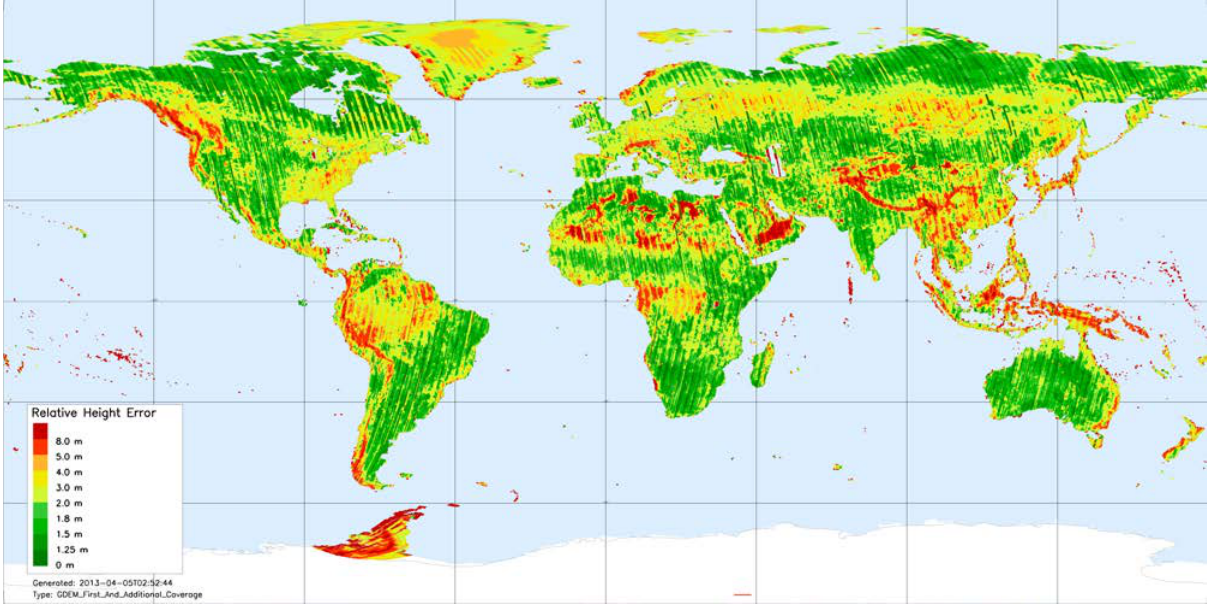
Figure 5: Global height error map of TanDEM-X data takes acquired during the first year campaign plus some additional acquisitions between Dec. 2010 and Jun. 2012. The acquisitions of the second year are currently in the processing